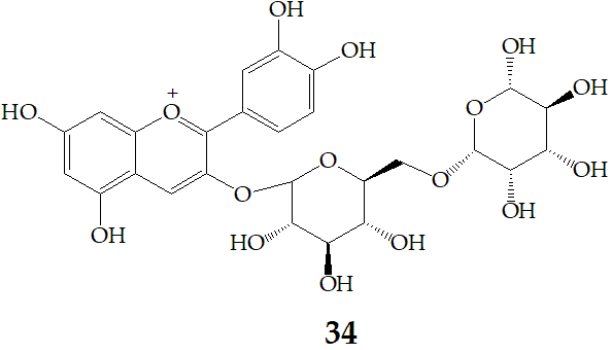
Figure 9. Chemical structures of compound 34 .